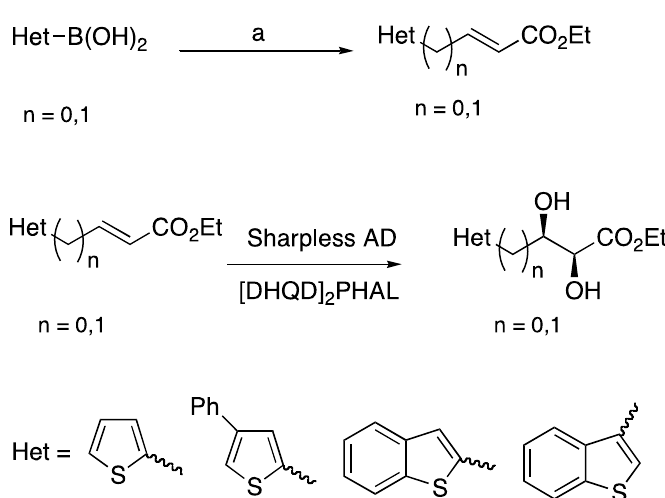
Scheme 1. Suzuki coupling and AD